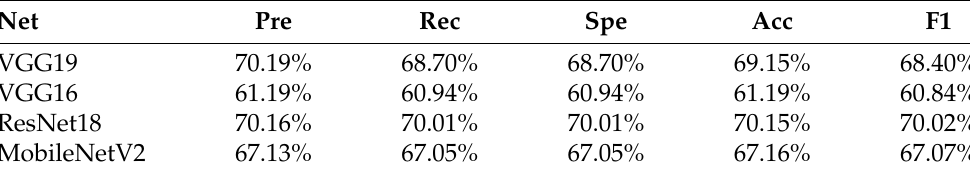
Table 5. Macro-average performance for testing on COVID-CT with